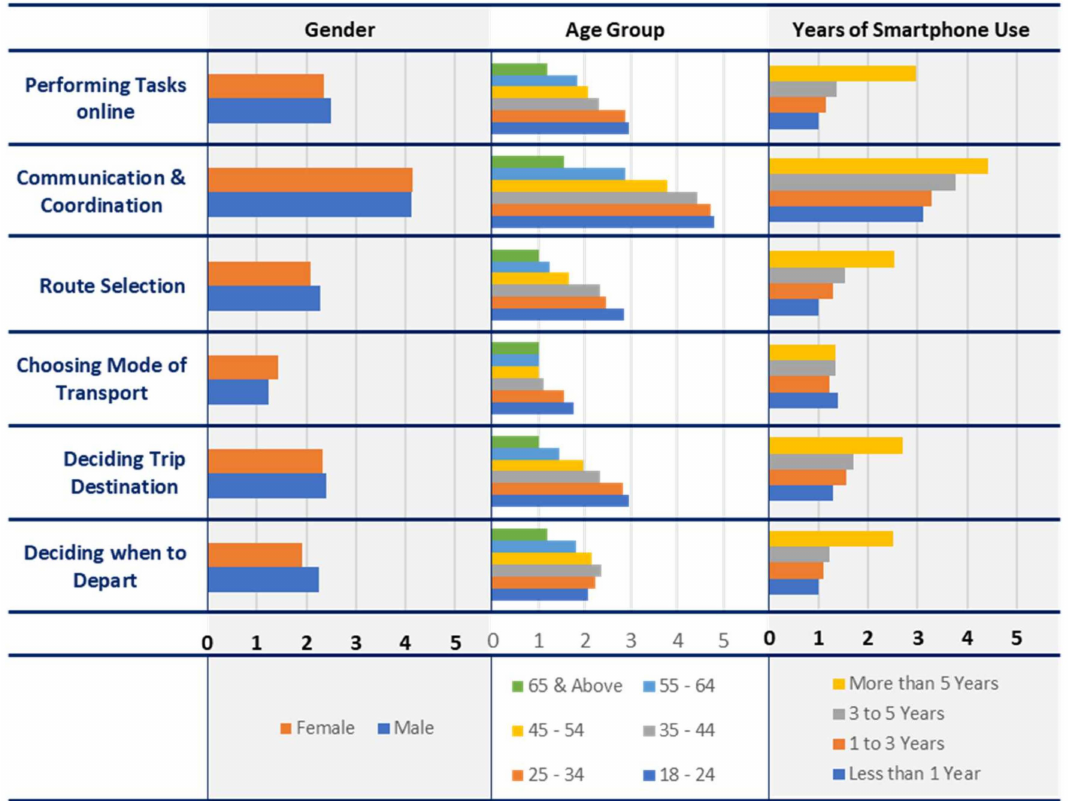
Figure 1. Personal level mean scores for trip planning